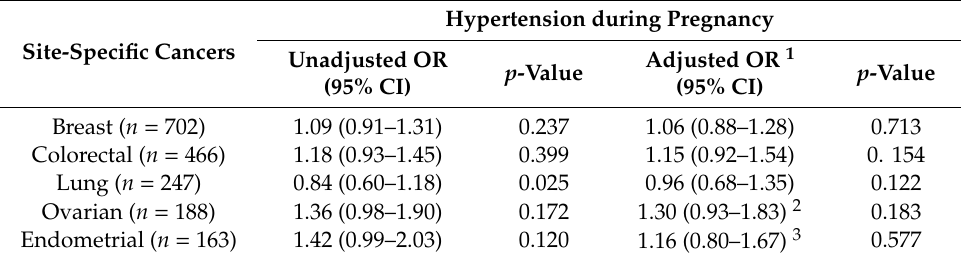
Table 3. Hypertension during pregnancy and unadjusted and adjusted odds ratios with corresponding 95% CIs of incident site-specific breast, colorectal, lung, ovarian and endometrial